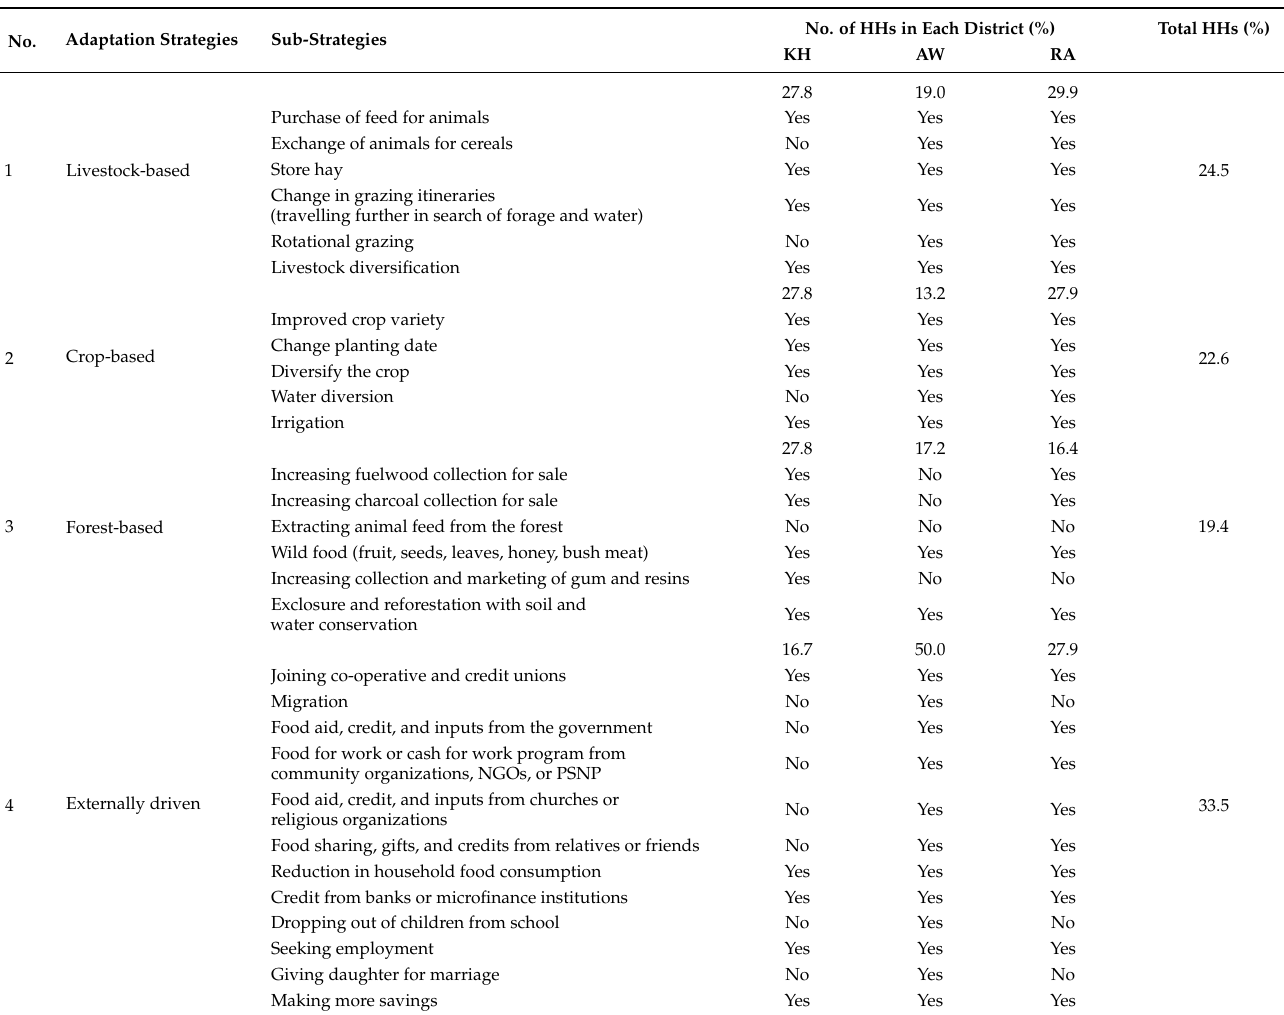
Table 5. Major adaptation strategies applied (%) to reduce impact of climate change in three districts of Tigray Regional